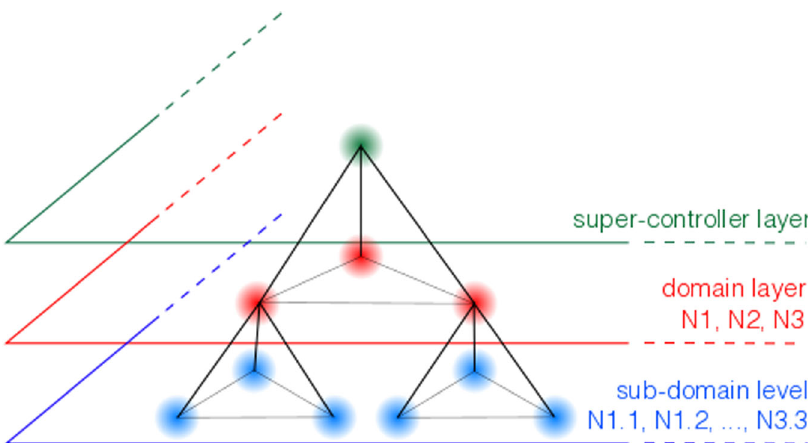
Fig. 1 Proposed subsidiary organisation of a QIN, reminiscent of software-de fi ned networks. The fi gure shows the super-controller layer (green), the domain layer (red) and the sub-domain